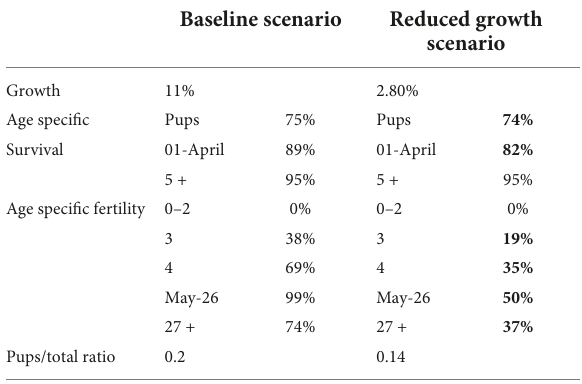
TABLE 2 The age-specific demographic rates predicted for a population under different growth conditions. Baseline